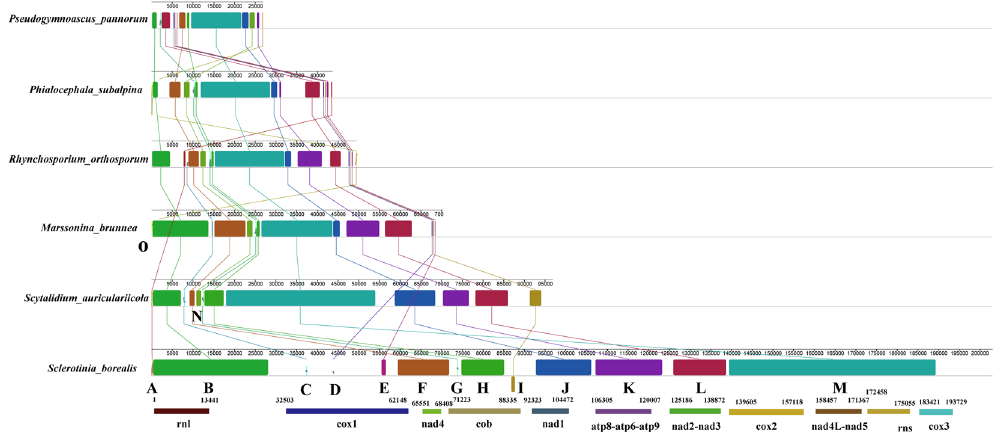
Figure 5. Mitogenome synteny among six Leotiomycetes species. Synteny analyses were generated in Mauve 2.4.0. Fifteen homologous regions were identified among the six mitogenomes. The sizes and relative positions of the homologous fragments varied across the